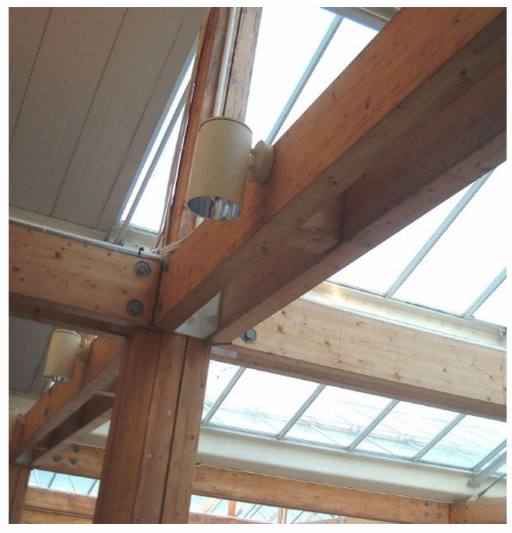
Figure 3. Glulam (source: